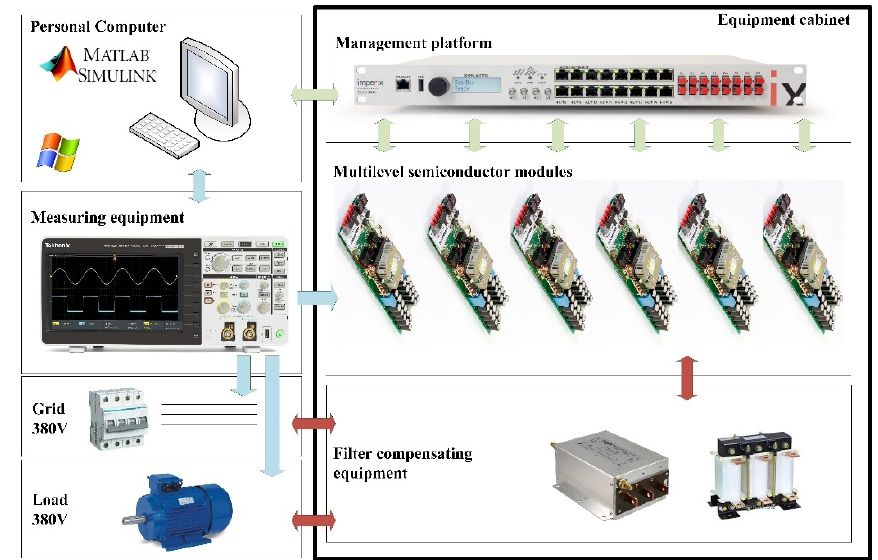
Figure 5. Main laboratory equipment. Table 2. Main equipment